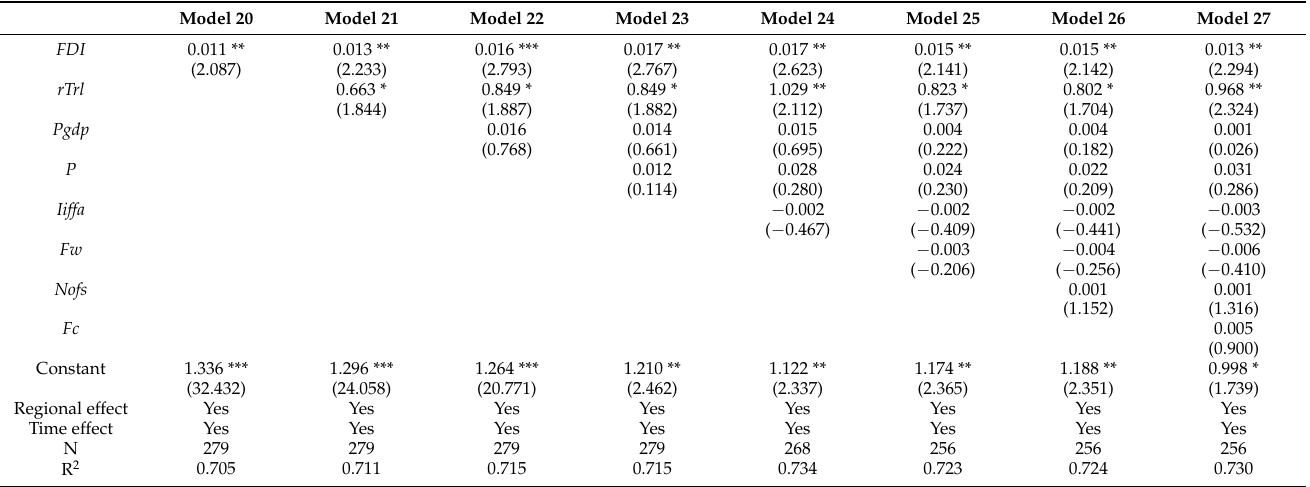
Table 9. Robustness test regression results for the baseline